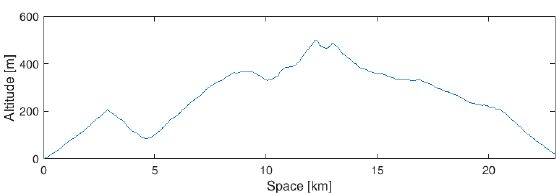
Figure 10. Mountain mission 1 altitude profile.